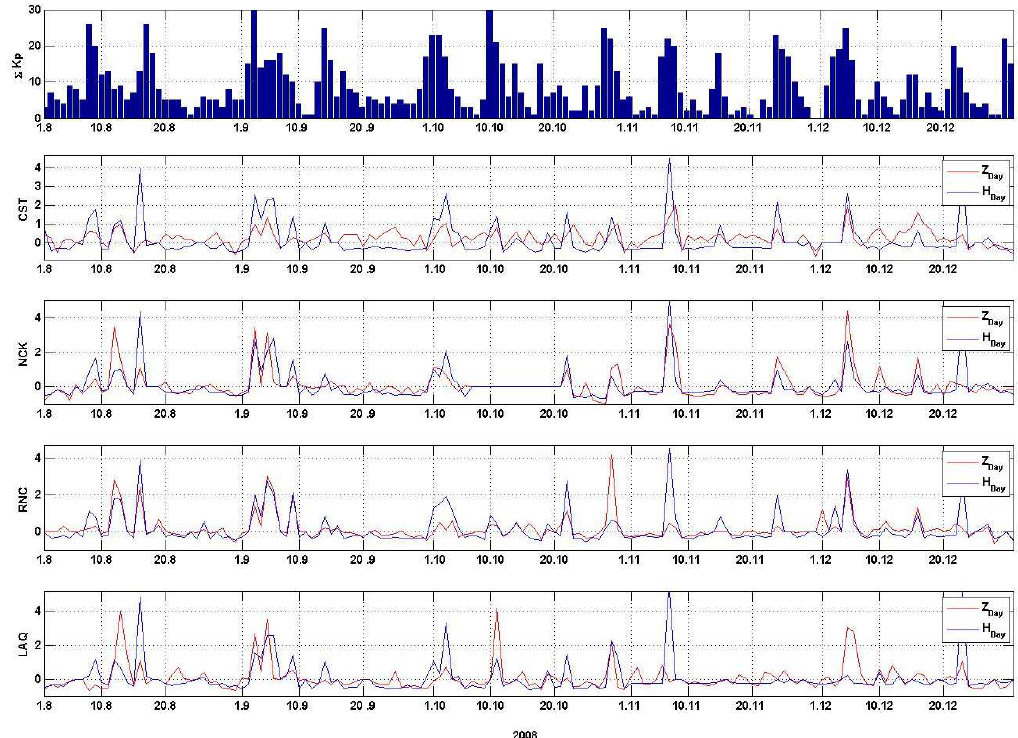
P K p and standardized daily horizontal (blue) and vertical (red) PSD from 1 August 2008 to 31 December 2008 for CST, NCK, Figure 3 Fig. 3. RNC, and LAQ station in a seismic quiet time